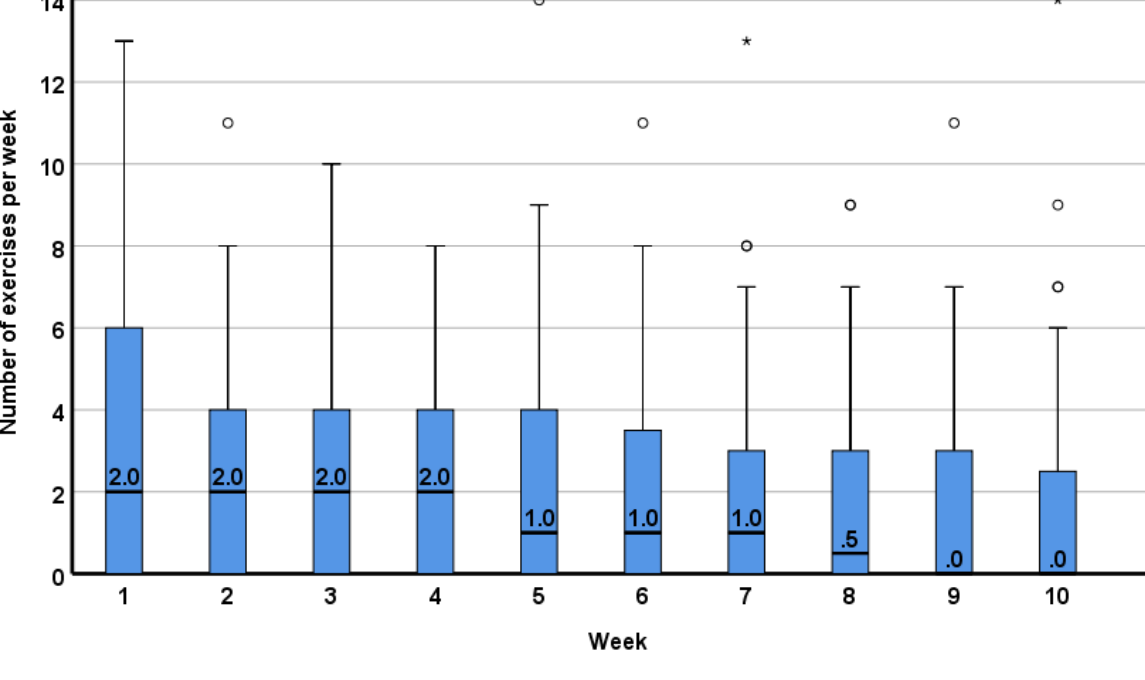
Figure 3. Completed app exercises by continuous app users within a 10-week app intervention (n=54) per week (median, interquartile